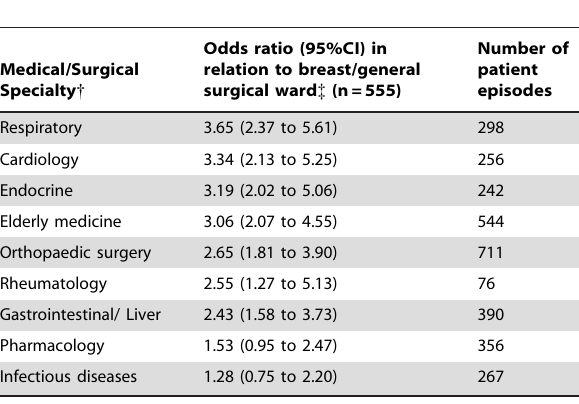
Table 1. Odds of experiencing an adverse drug reaction by ward